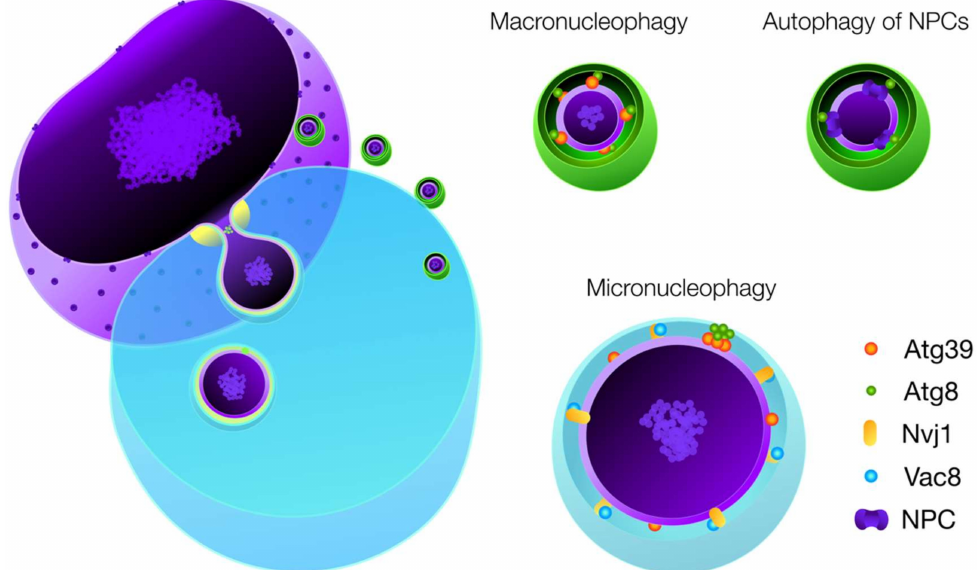
Figure 2. The two principle modes of nucleophagy in S. cerevisiae . Macronucleophagy is a selective macroautophagic mode dependent on cargo receptor Atg39. Atg39 interacts with Atg8 in the autophagic membrane to form autophagosomes around micronuclei, which are ultimately transferred to the vacuolar lumen. Autophagy of nuclear pore complexes (NPCs) was shown to be a process separate from macronucleophagy, occurring independent of Atg39, instead recognizing cargo by interaction of Atg8 with Nup159 within the NPC. Micronucleophagy (piecemeal microautophagy of the nucleus) also depends on Atg39. Its larger cargo diameter of ~700 nm for micro- when compared to ~380 nm of macronucleophagic vesicles, restriction to the nuclear vacuolar junction (NVJ) and a punctate Atg8 positive structure between the tips of the vacuolar invagination set it apart from